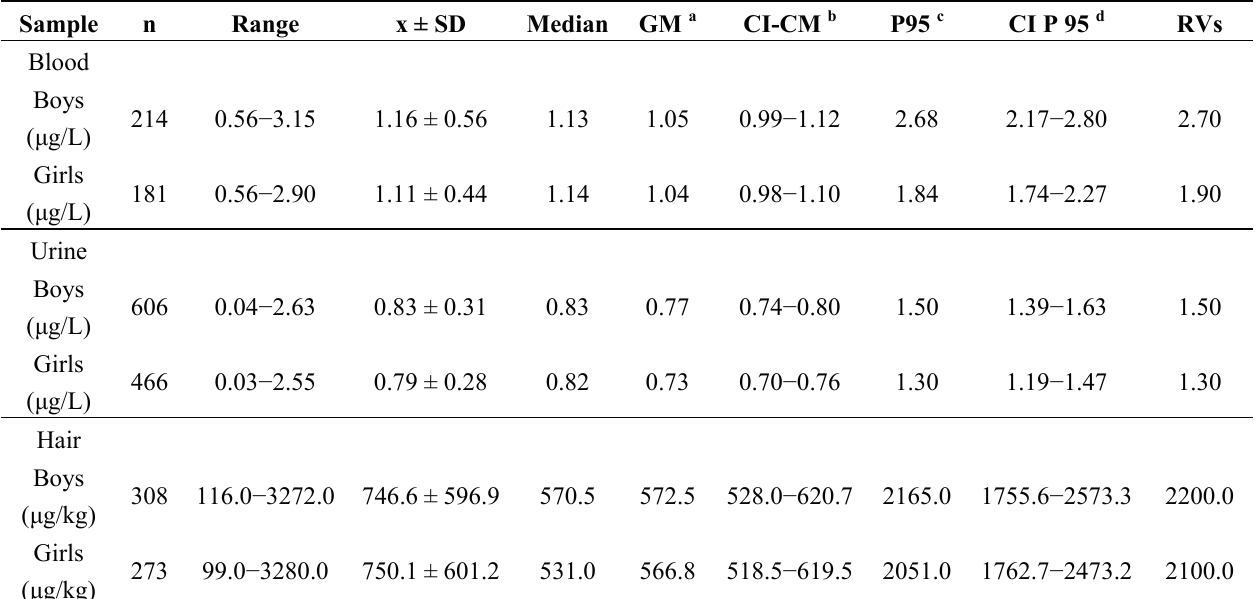
Table 3. Mercury levels in blood, urine, and hair of boys and girls of children aged 0 to 6 years.